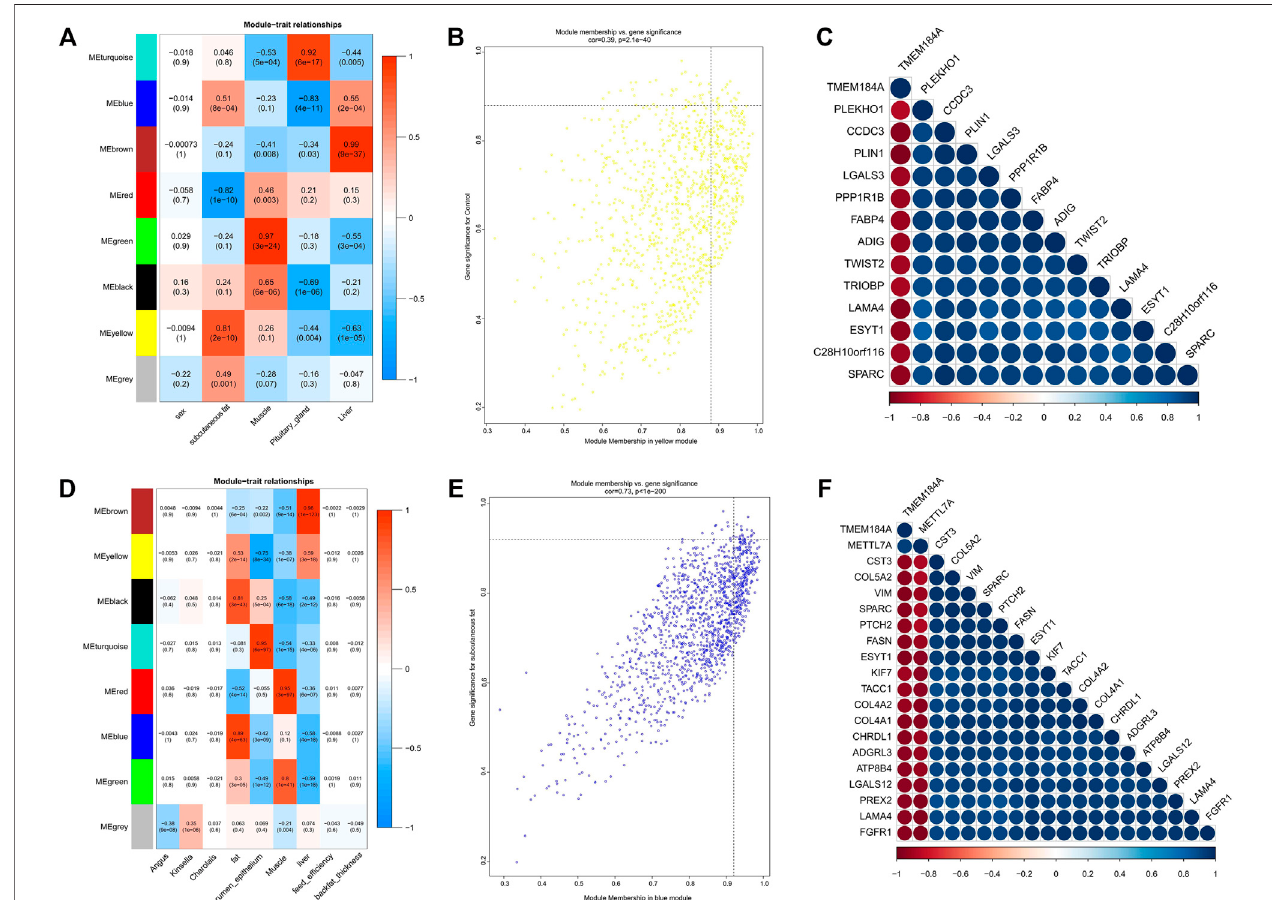
FIGURE 4 | Module-trait correlations analysis of GSE65125 and GSE116775. (A,D) Correlation heatmap between modules and trait; (B) The MM and GS for abdominal subcutaneous fat in the yellow module; (C) The correlation relationship of top 14 genes with high MM and GS in the yellow module; (E) The MM and GS for dorsal subcutaneous fat in the blue module; (F) The correlation relationship of top 20 genes with high MM and GS in the blue module.